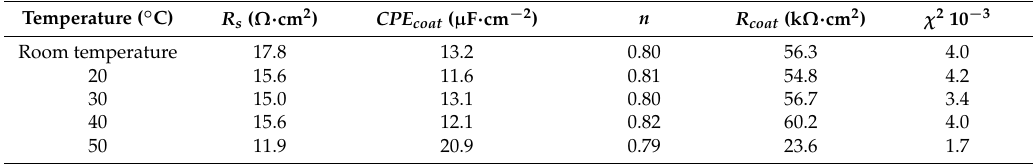
Table 5. The fitting results of EIS shown in Figure 6.